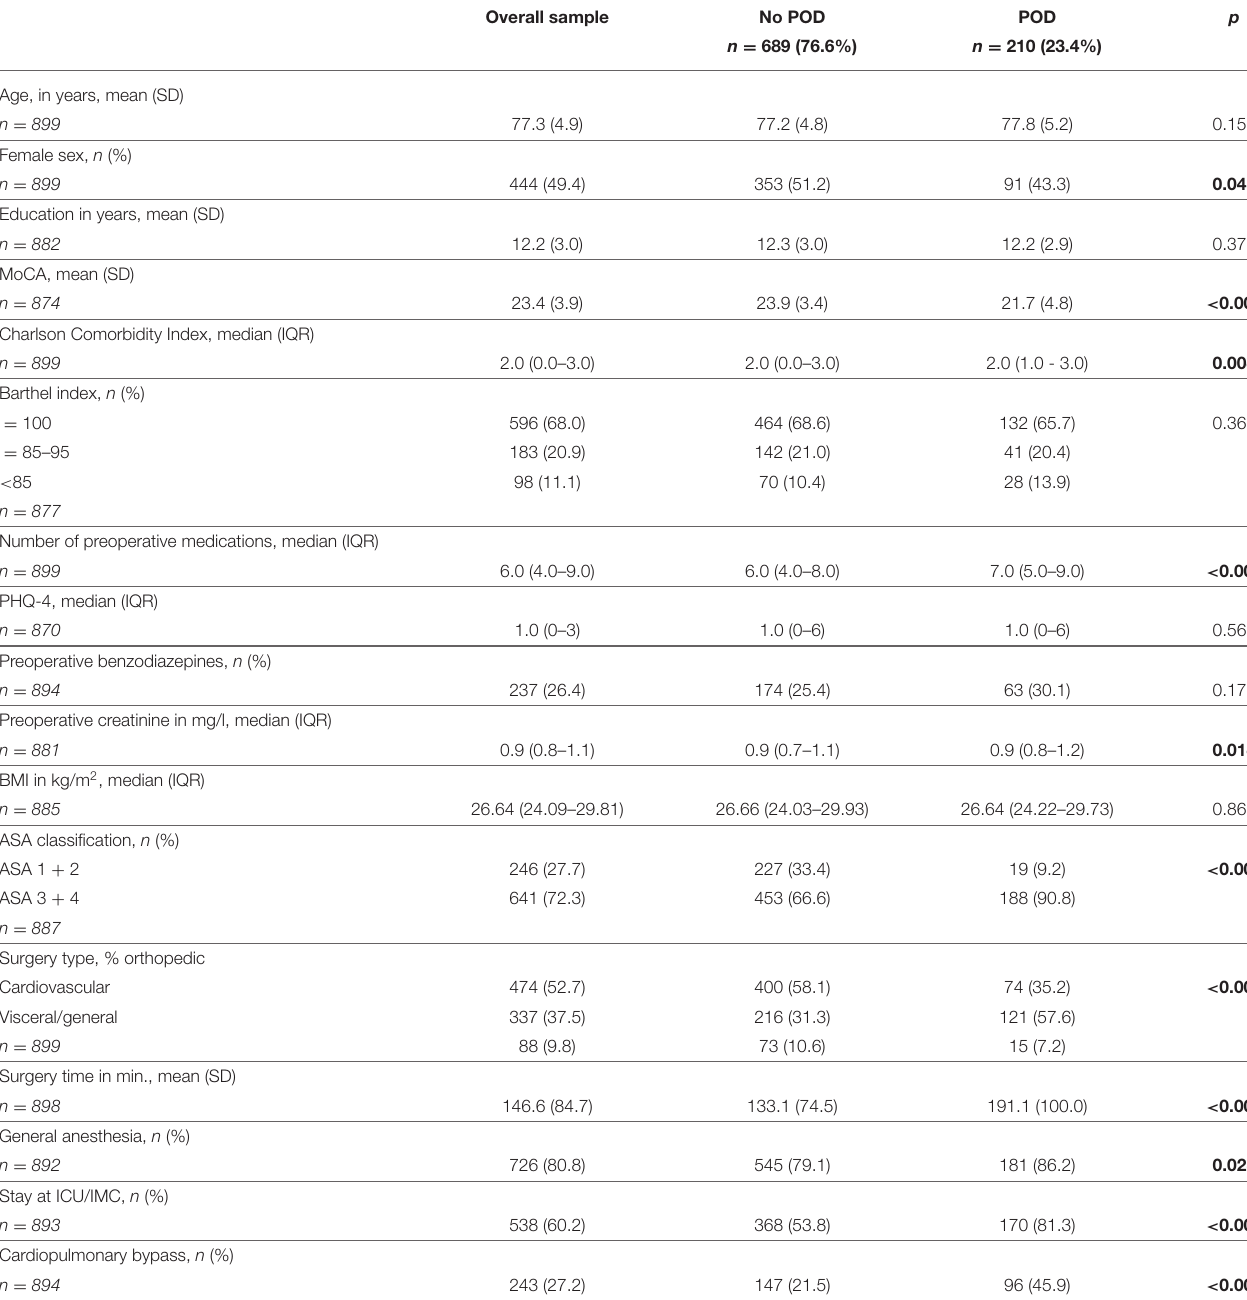
TABLE 1 | Sociodemographic and clinical characteristics of enrolled patients.